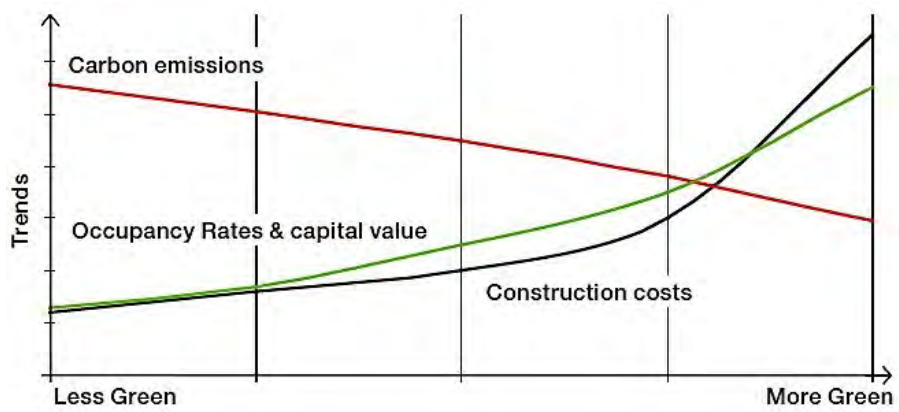
Figure 4. Effect of going green on CO2 emissions, occupancy rates, and construction costs (Langdon, 2007).